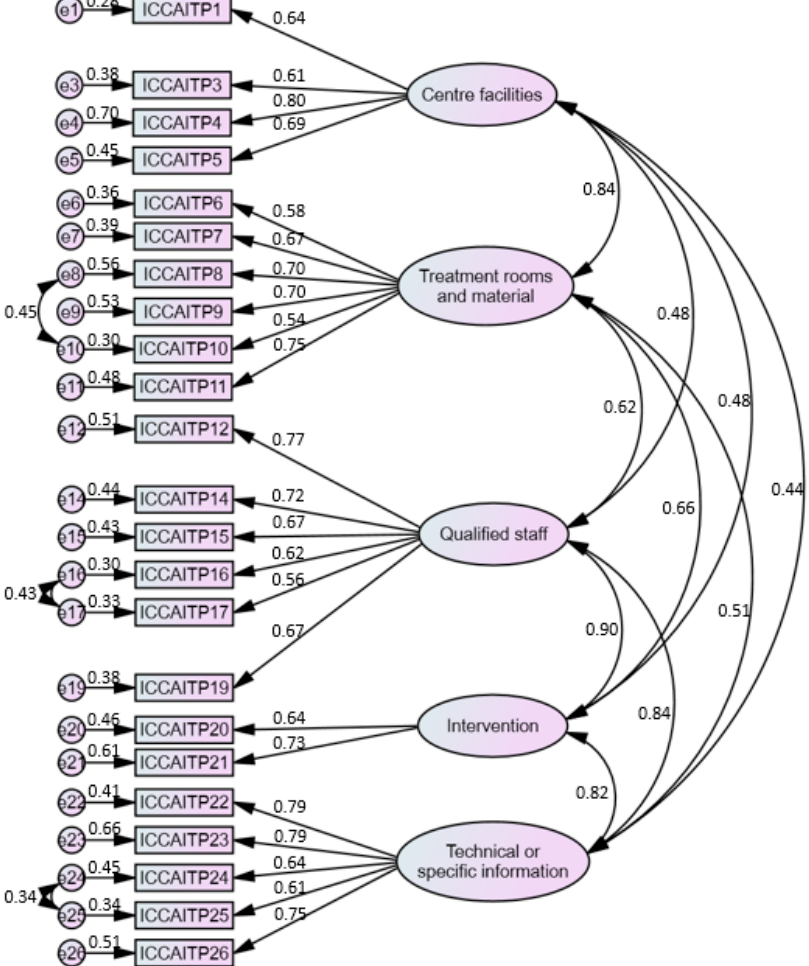
Figure 1. Confirmatory factor analysis estimates of the 23-item questionnaire.